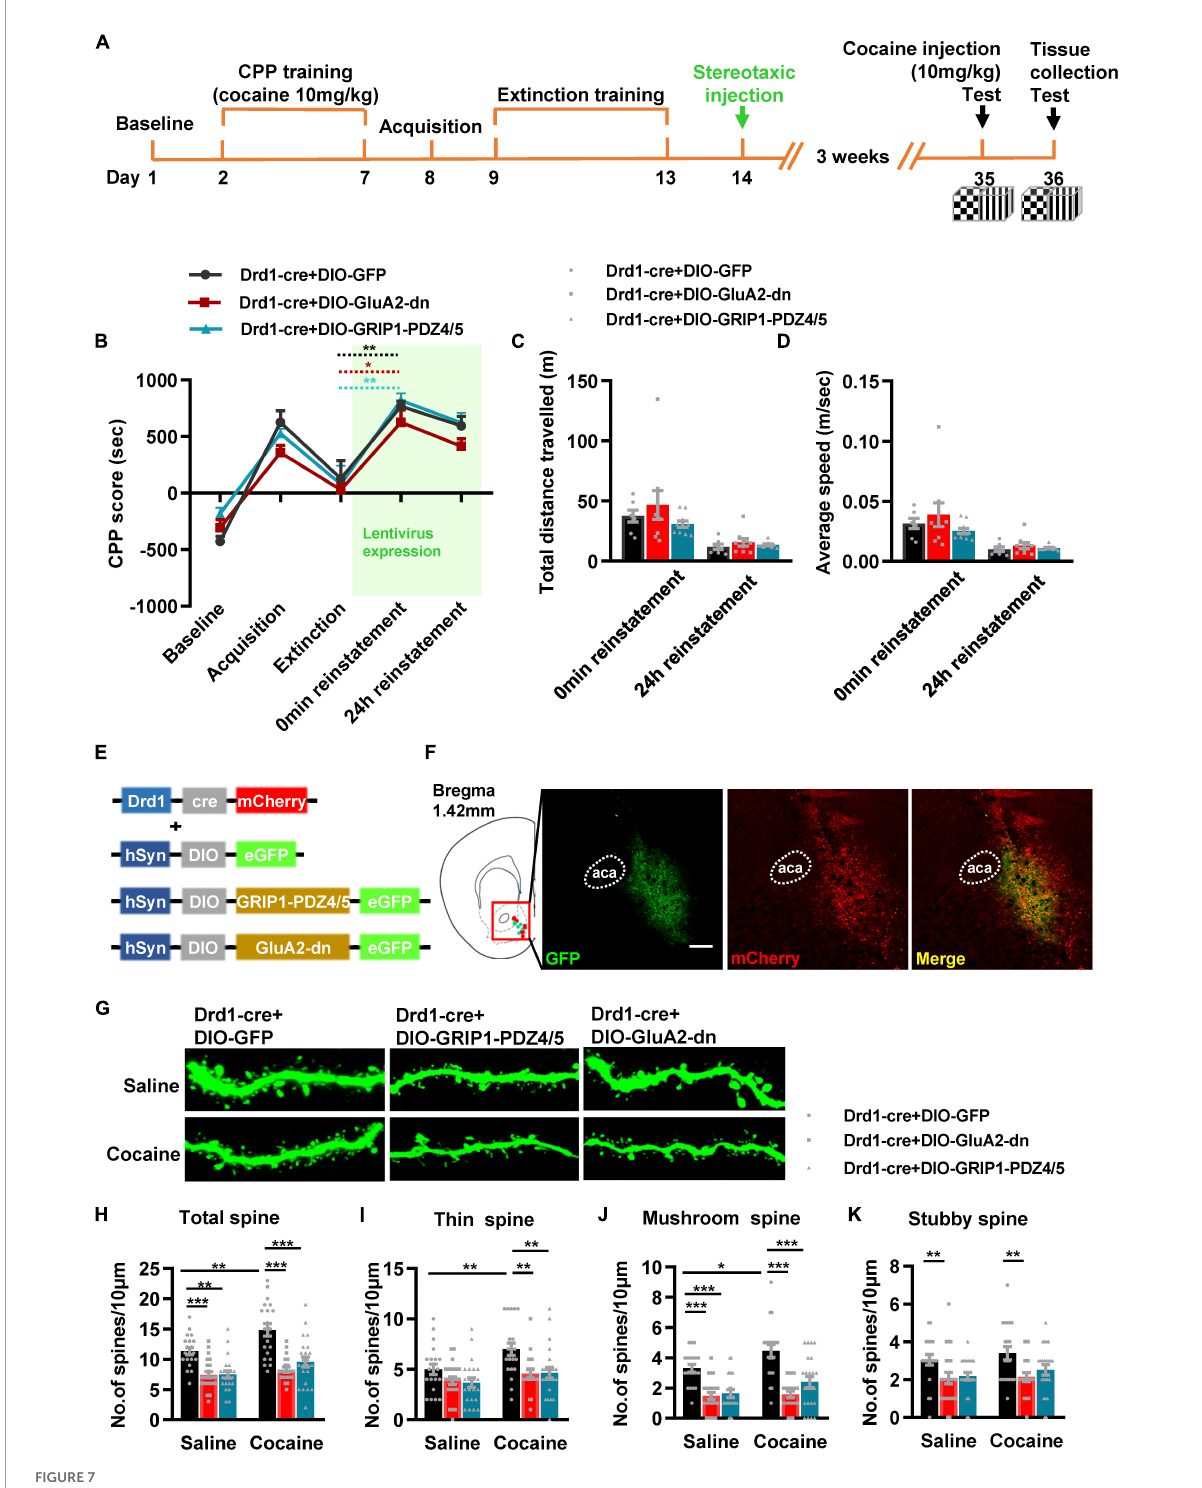
FIGURE7 Interference with GRIP1 and GluA2 interaction in D1-MSNs does not affect cocaine-induced reinstatement but blocks the associated spine plasticity of D1-MSNs. (A) Experimental design for the behavioral tests and spine analysis. Two-compartment unbiased CPP models were used. (B) GluA2-dn and GRIP1-PDZ4/5 expressed in D1-MSNs did not affect cocaine-induced reinstatement in the unbiased CPP test. (C,D) Total distance traveled and average speed during 0 min reinstatement. (E) Viral vectors used to interfere with the interaction of GRIP1 and GluA2 in D1-MSNs. (F) Representative images of the injection site. (G) Representative images of GFP-labeled dendrites. (H–K) The statistical data for stubby spine, mushroom spine, thin spine, and total spine density. n = 20–30 dendrites obtained from 8–10 mice per group. * P < 0.05, ** P < 0.01, and *** P <